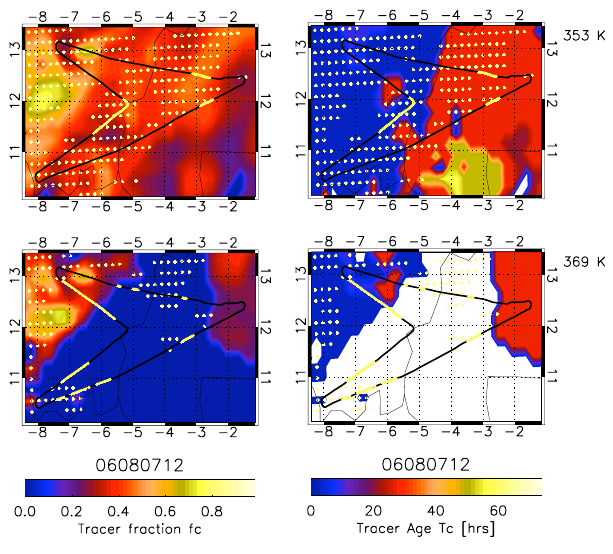
Fig. 7. Left: maps of f c estimated from the BOLAM model (see text for definition) for two theta layers (368–369K above the main convective levels and at 352–354K) for 7 August 2009 at 15:00UTC. Yellow dots indicates where BOLAM RH ice exceeds 100%. The M55 path is reported in the plot: yellow thick lines in- dicates the part of flight occurring at the theta level reported in the figure. Right: same as left but for t c